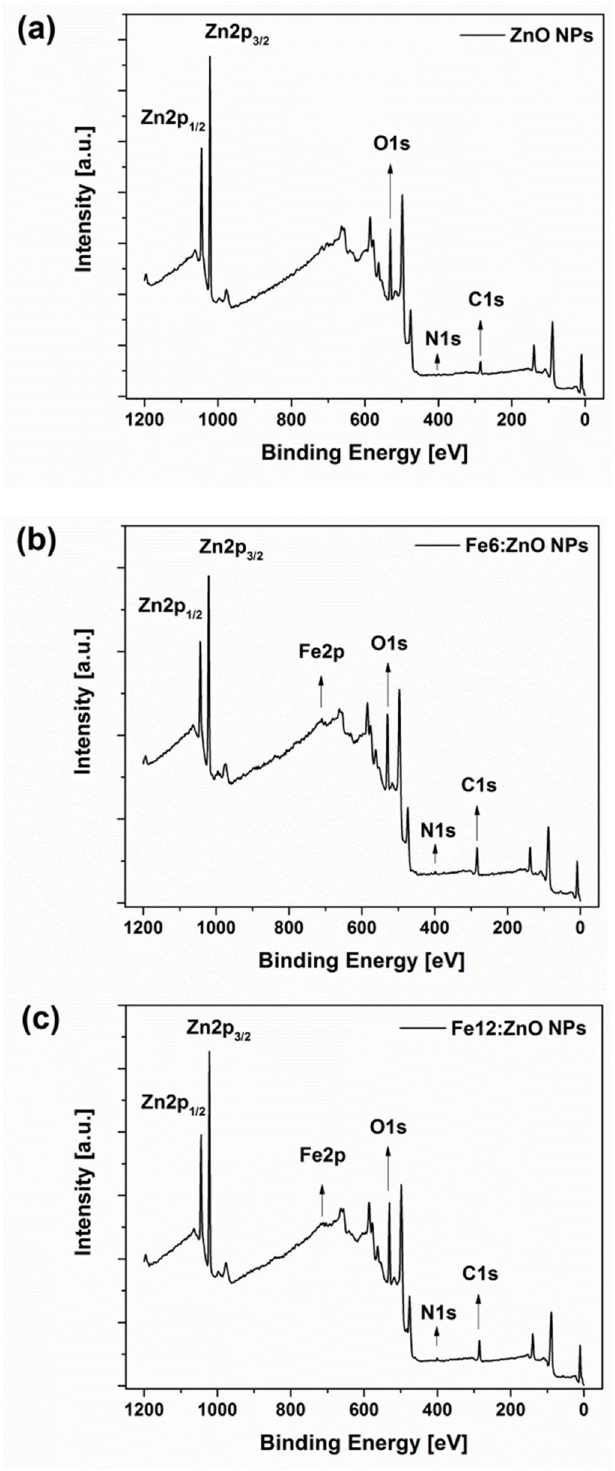
Figure 3. Wide energy range XPS spectra for undoped ZnO ( a ), Fe6:ZnO ( b ) and Fe12:ZnO ( c ) NPs.